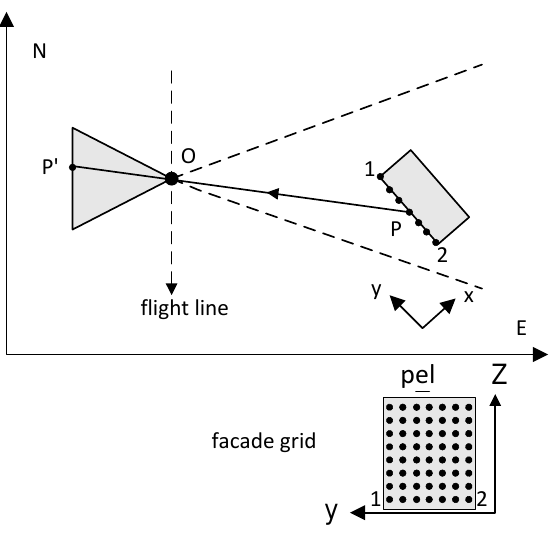
Figure 5. Principle in the derivation of façade plots with photo texture. A regular grid of small pixel size (pel) is established in the modelled yZ-system and supplemented with colour (r,g,b- values), which are found in the image by back projection (P→P’).